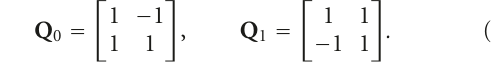
Figure 3: Quincunx filter